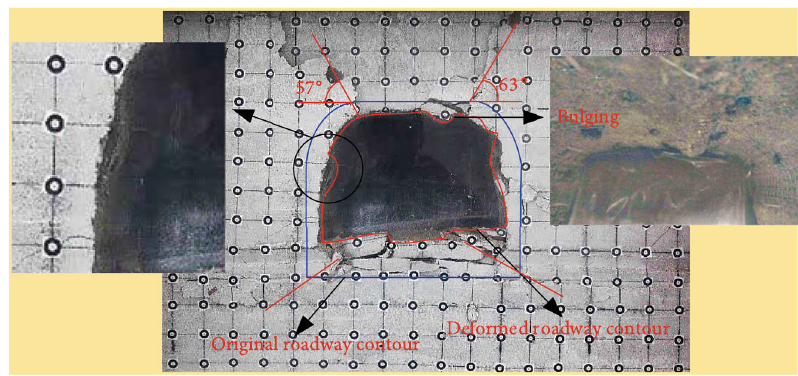
Figure 8: Deformation roadway pro fi le during mitigating deformation